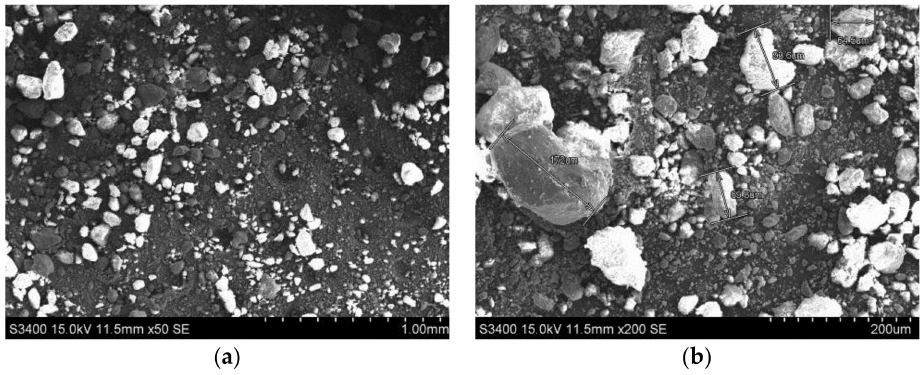
Figure 4. The Ouarzazate sand particles at 50 × magnification ( a ) and 200 × magnification ( b ).